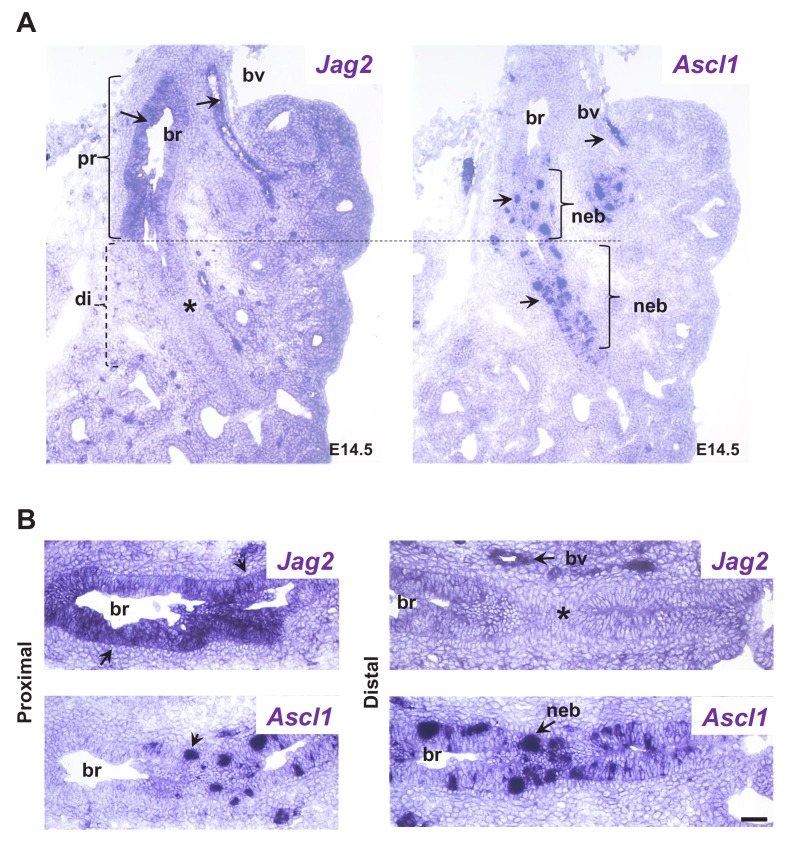
NEBs emerge in non-Jag expressing domains of the developing airway epithelium.In situ hybridization (Jag2, Ascl1) in serial sections of E14.5 lungs (A) low magnification image showing both Ascl1-expressing cell clusters (NEBs) and Jag2 epithelial signals in proximal (pr) but not in more distal (di) main bronchus (br), where NEBs emerge in Jag2 negative (*) epithelium. Dotted line depicts the Jag2 positive and negative domains (in brackets). (B) Higher magnification of the bracketed areas in (A). Strong signals in blood vessels (bv) and nerves (nv) confirm specificity of Jag2 and Ascl1 staining, respectively (see also Figure 1—figure supplement 1 for Jag1 expression). Scale bar represents 40 μm.